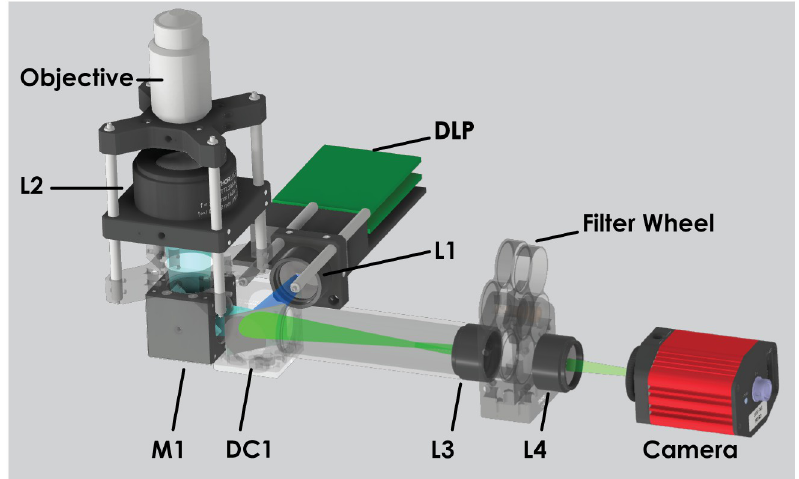
Fig 2. Schematic of the home-built LED-based SIM